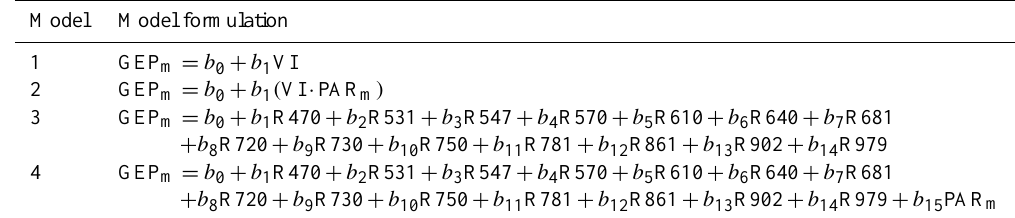
Table 3. The four models for GEP m estimation tested in the presented study.